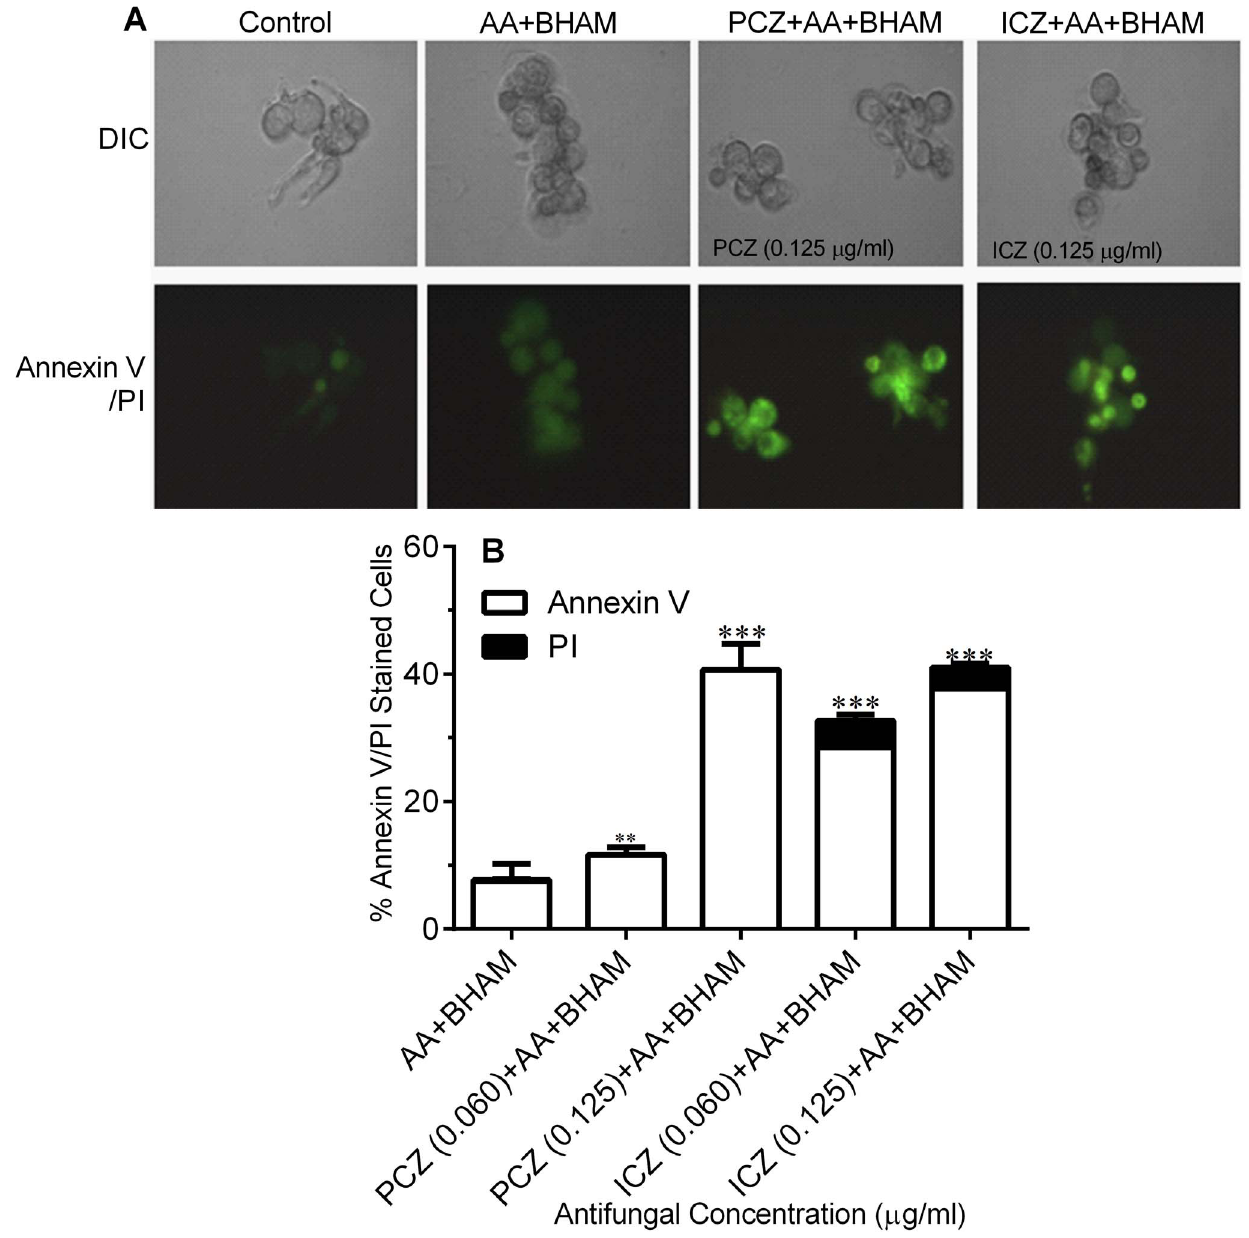
Figure 5. Representative fluorescent images of R.oryzae cells treated with PCZ or ICZ in combination with AA and BHAM, cells treated with only AA and BHAM, and untreated control cells. (A) Annexin V/PI double staining showing apoptotic cells (green fluorescence) and necrotic cells (red fluorescence). DIC, differential interference contrast. (B) Percentages of cells displaying annexin V/PI double staining. **, p , 0.001, and ***, p , 0.0001, compared to AA + BHAM treated